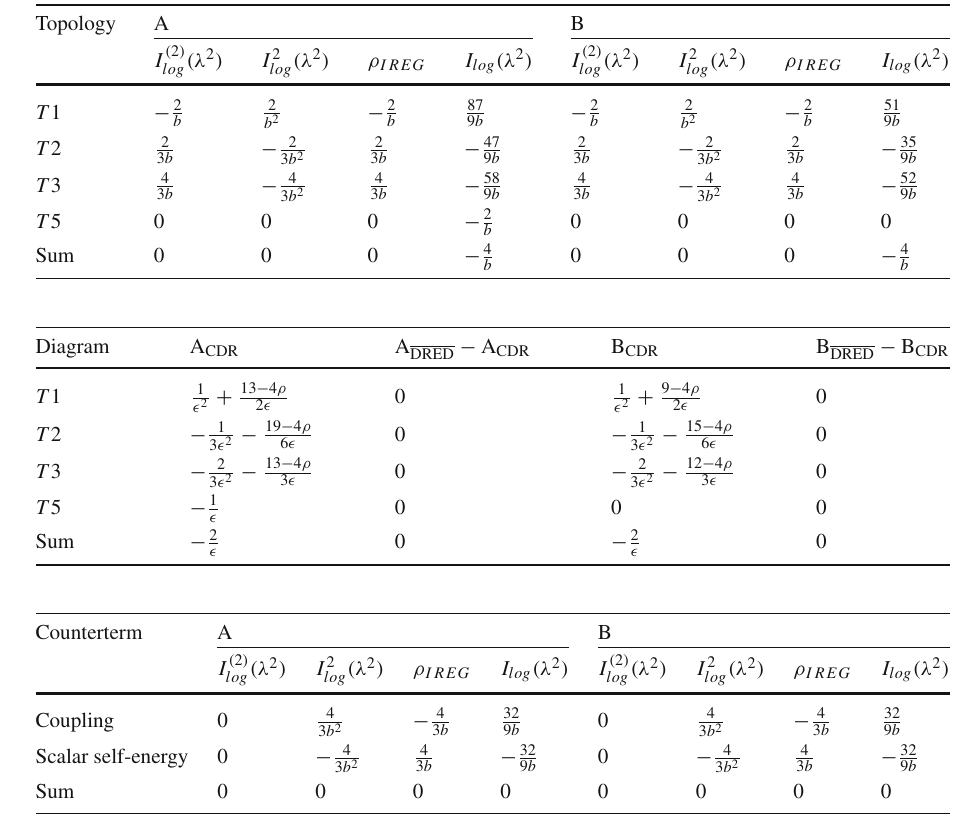
Table 4 Counterterm results for scalar QED using IREG where